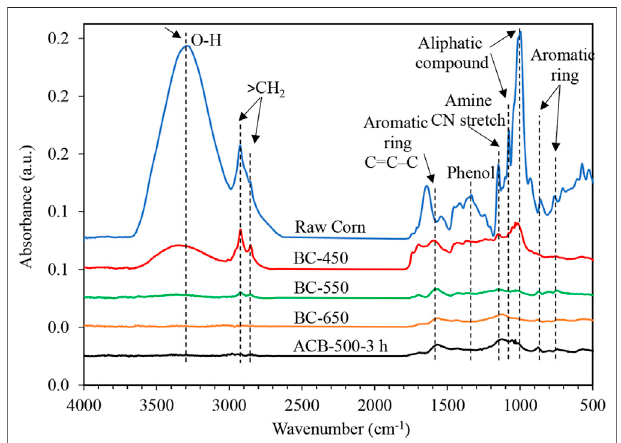
FIGURE 5 | FTIR spectra of raw corn, bio-char produced at 450, 550, and 650 ° C (holding time: 30 min), and activated bio-char produced at 500 ° C with activation holding time of 3 h.